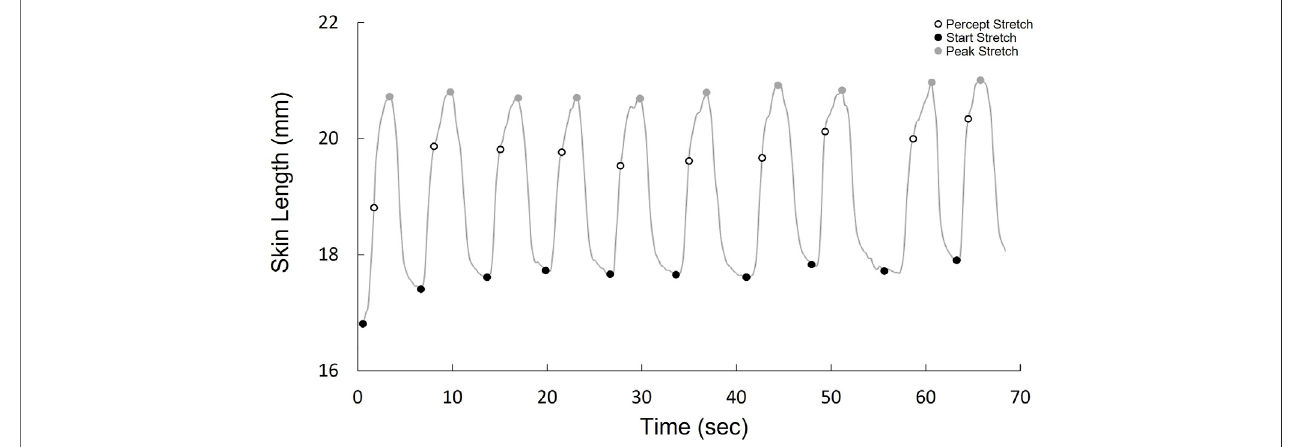
FIGURE 2 | Kinematic stretch data over one trial (10 cycles), demonstrating the cycle onset, when stretch is perceived, and peak stretch for each